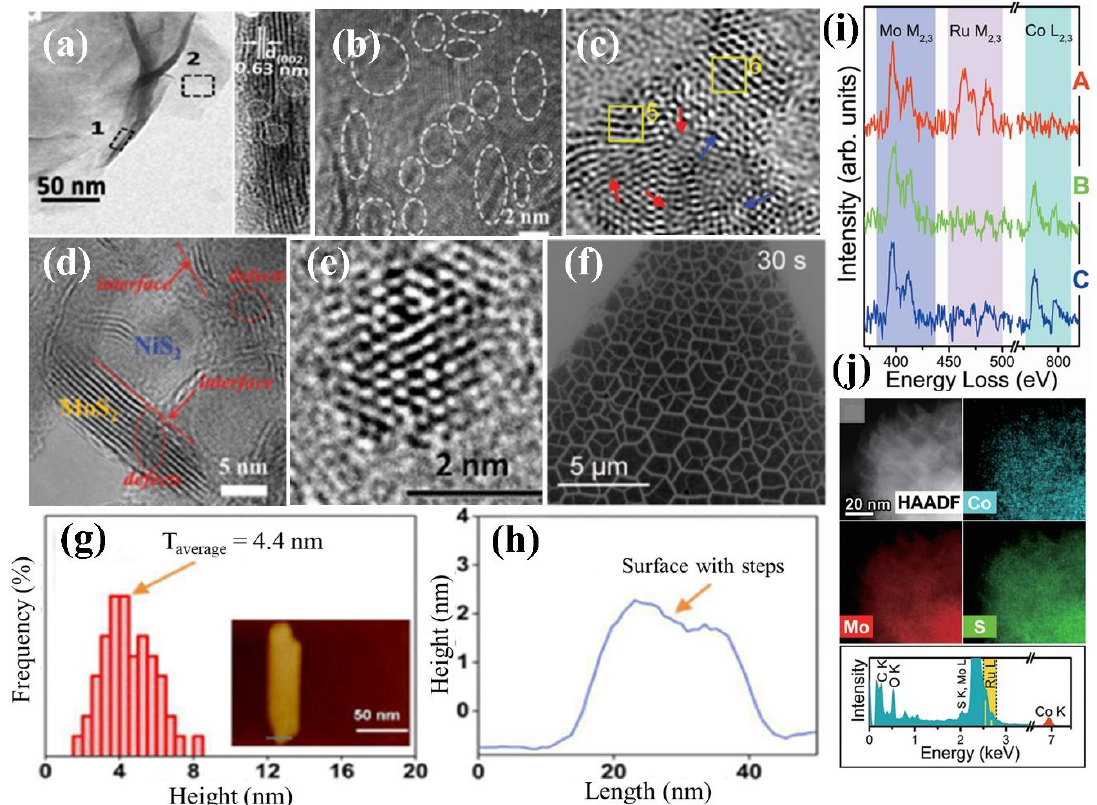
Figure 5. ( a ) TEM image for defect-rich MoS 2 nanoflower. Copyright 2018 Wiley. ( b )